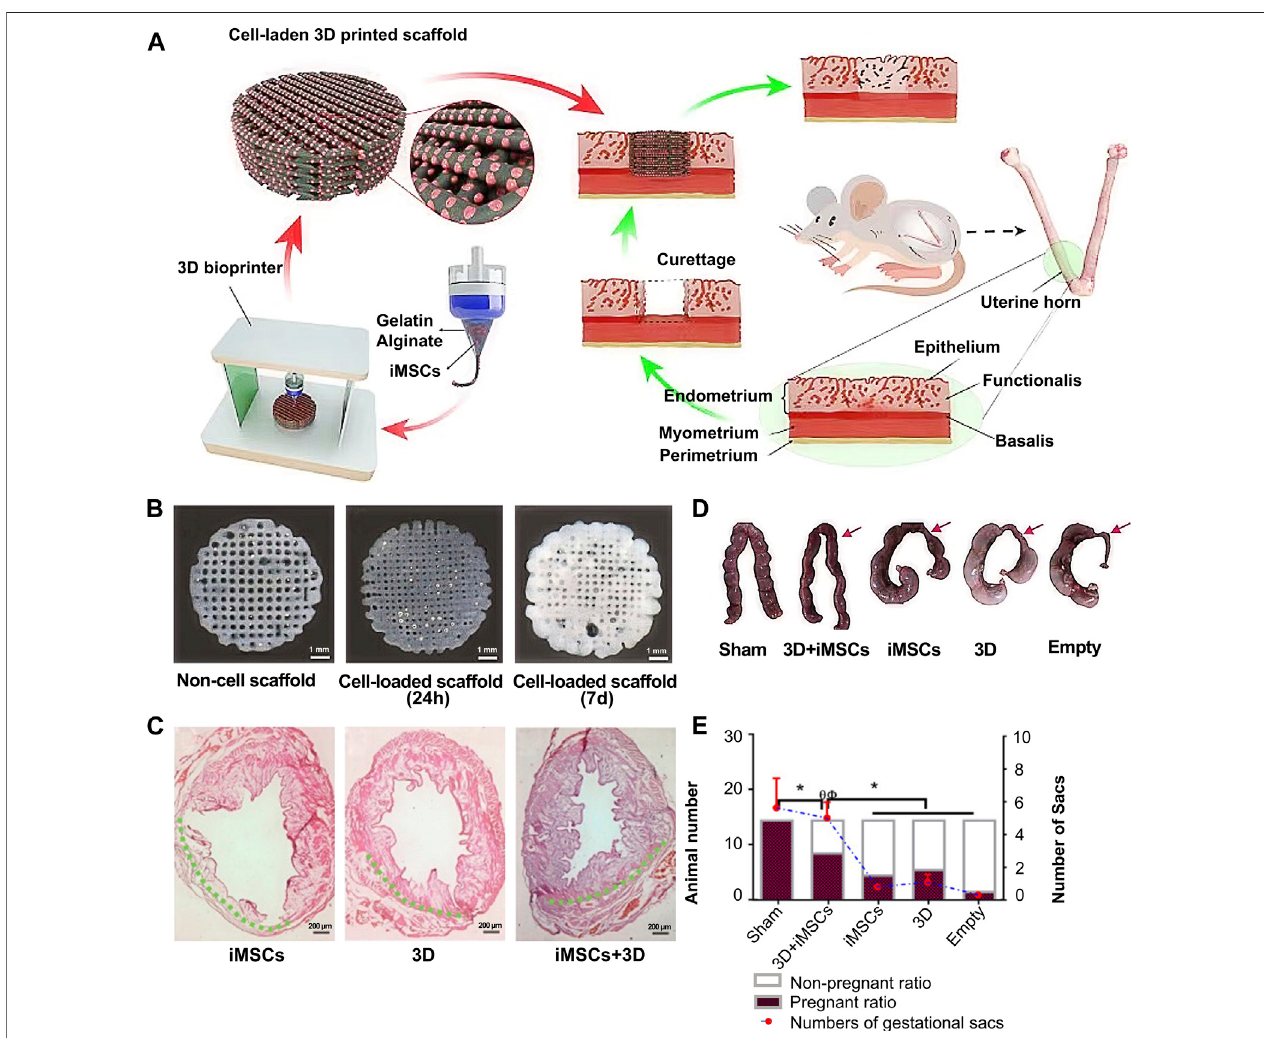
FIGURE 6 | Whole overview of 3D bioprinting a human iPSC-derived MSC-loaded scaffold. (A) The whole preparation procedure of an alginate – gelatin hydrogel scaffoldand scaffoldimplantation. (B) Pictureoftheoriginalalginate-gelatinhydrogelandcell-loadedscaffoldat24 hand7 d (C) H&Estainoftheendometriumaftercell implantation, scaffold implantation, and cell-loaded scaffold implantation. (D – E) Outcome of endometrial receptivity after cell-loaded scaffold implantation. Reproduced with permission (Ji et al., 2020). Copyright 2021, Elsevier Ltd.